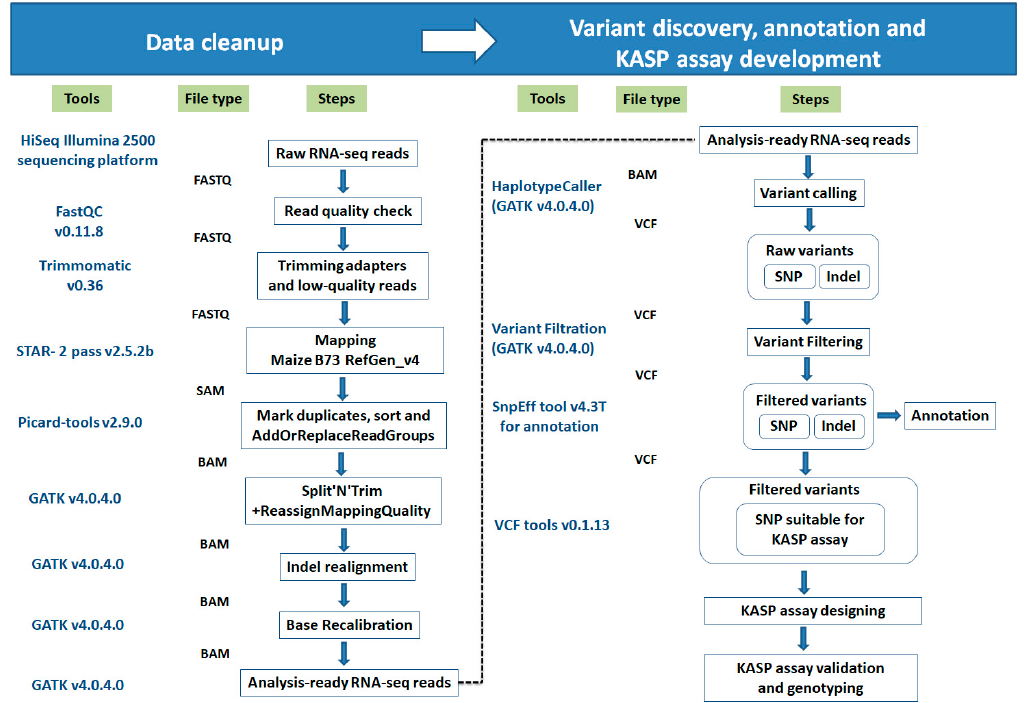
Figure 9. Variant calling pipeline . Schematic representation of the bioinformatics pipeline for